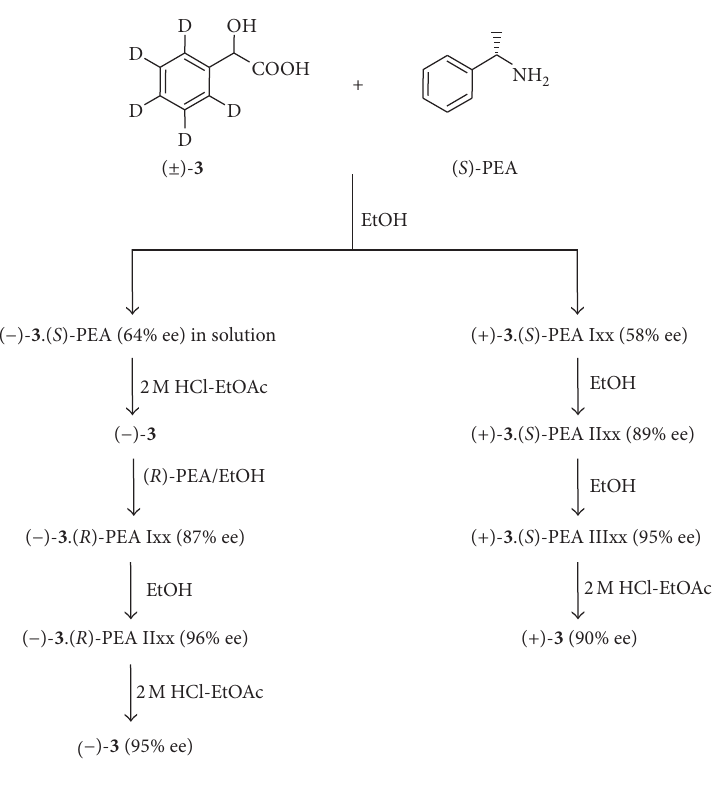
hydrate 4 , possible intermediate of step 2 in Scheme 𝑑𝑑 5